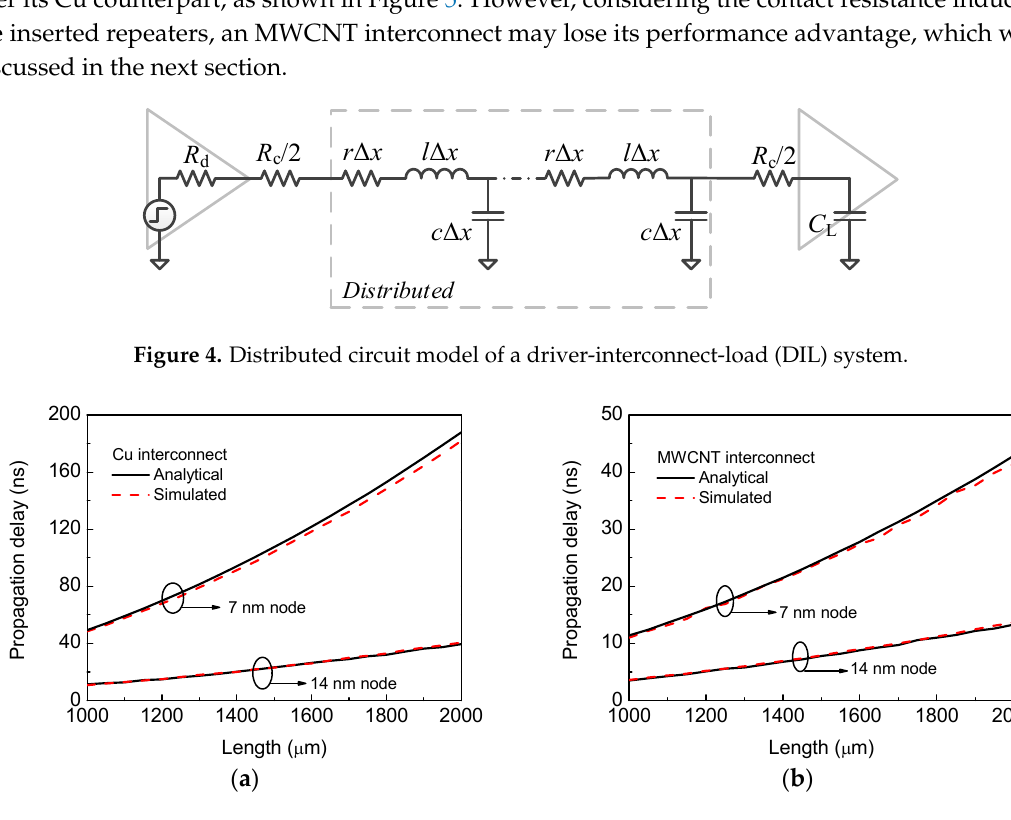
Figure 5. Propagation delays versus length in the intermediate-level ( a ) Cu and ( b ) MWCNT interconnects.